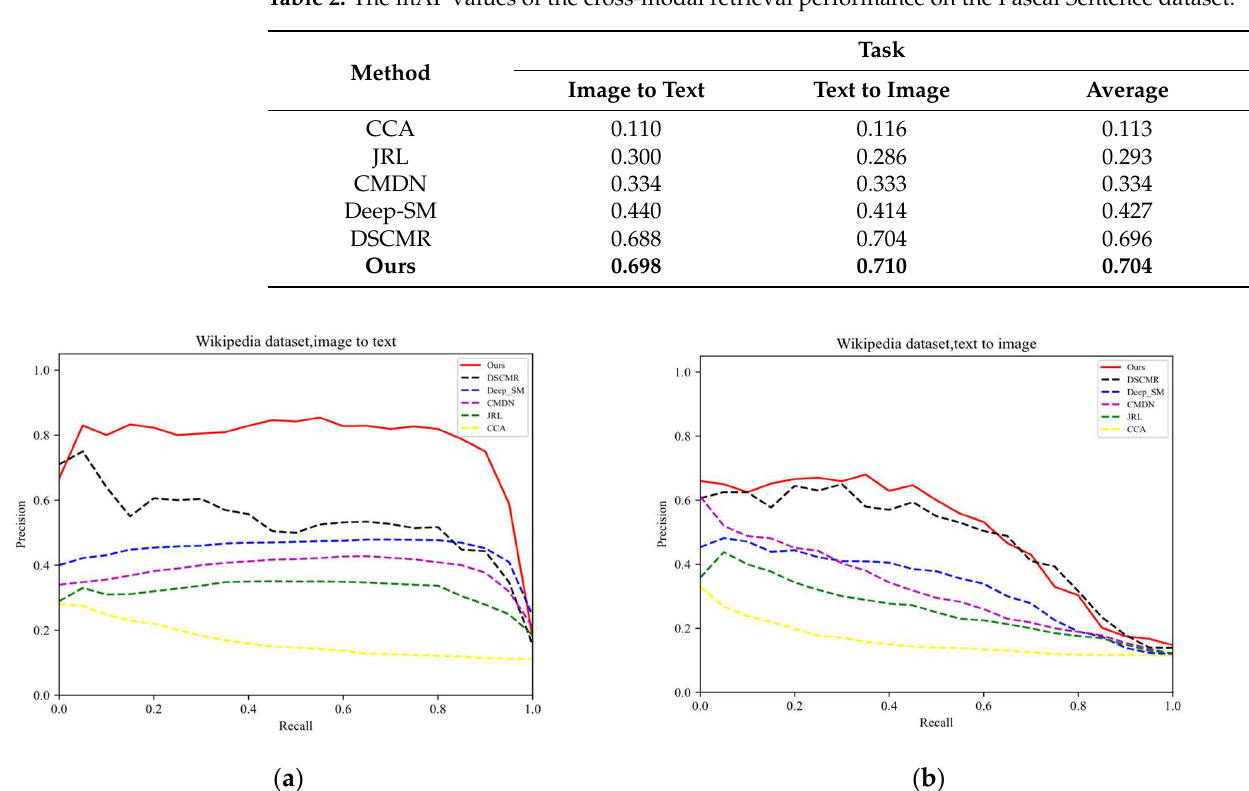
Figure 9. The PR curves of the cross-modal retrieval performance on the Wikipedia dataset. ( a ) The image to text task on the Wikipedia dataset. ( b ) The text to image task on the Wikipedia dataset.